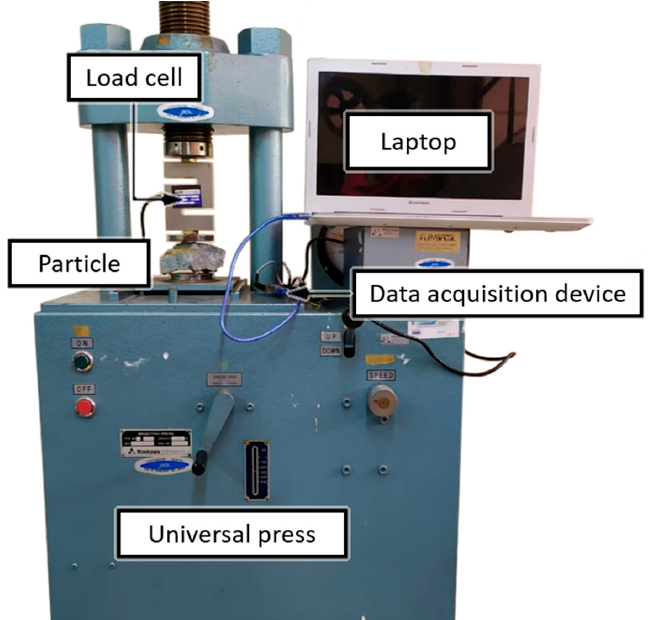
Figure 4. Uniaxial compression system used in unconfined testing of particles.